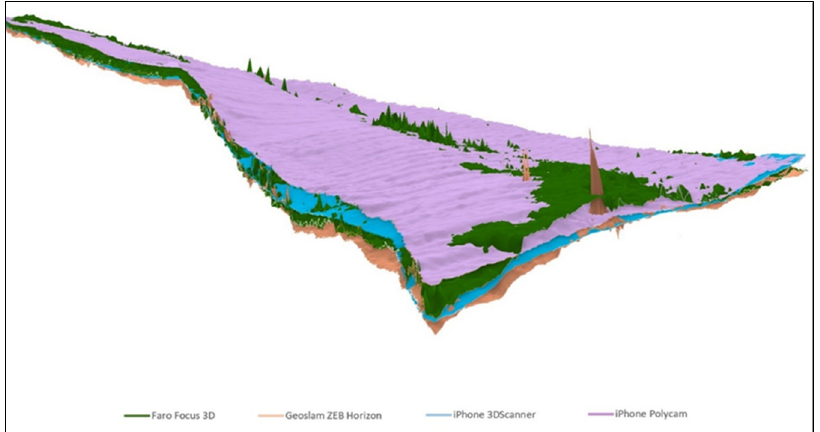
Figure 3. Digital surface model of each scanning method visualised from a part of road section No. 3 with a fivefold elevation change.